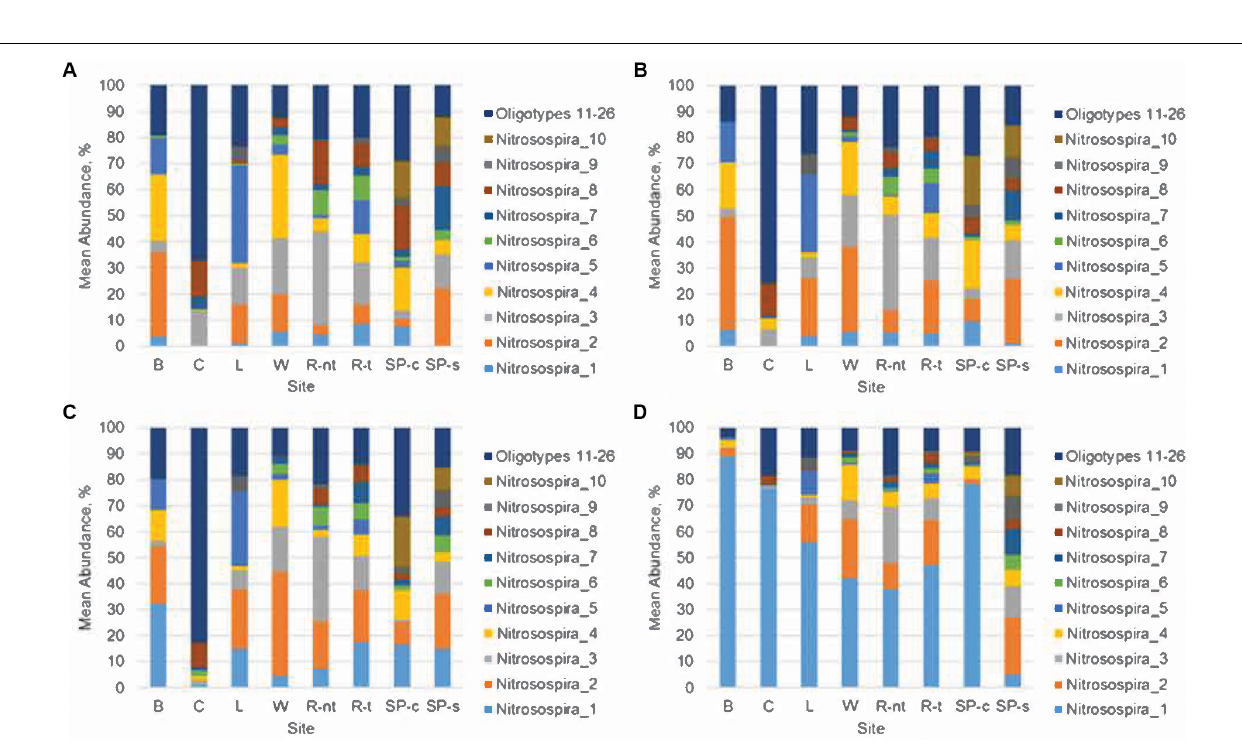
Frontiers in Microbiology |